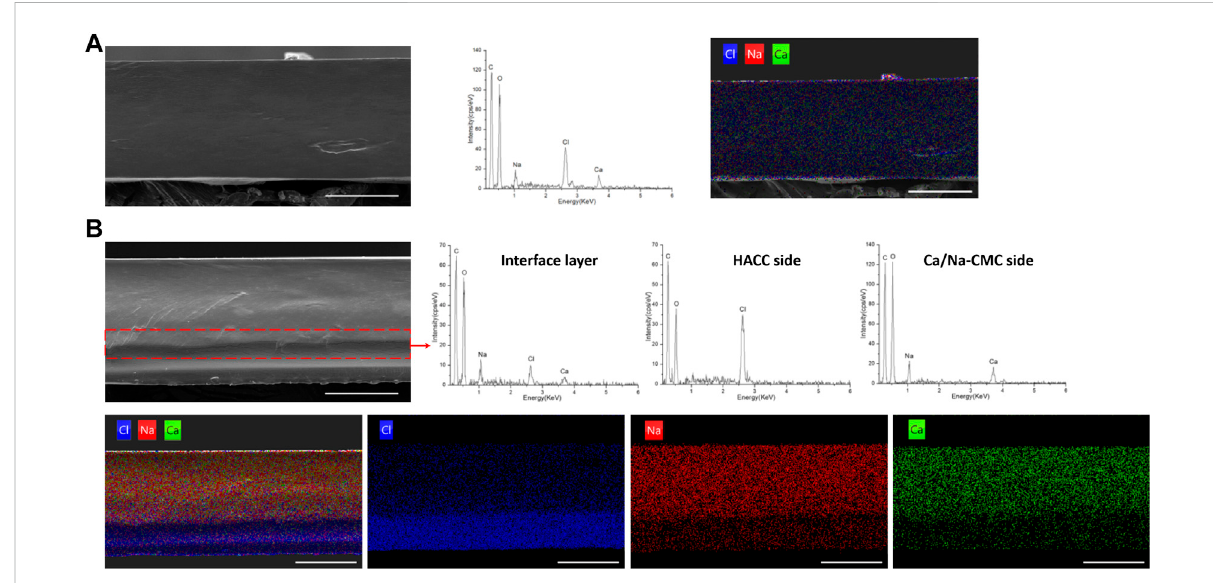
FIGURE 3 Morphology and composition analysis. (A) SEM image of the cross-section of BF, and corresponding EDS spectrum and mapping (chlorine, blue; natrium, red; calcium, green). (B) SEM image and corresponding EDS mapping of the cross-section of MF2, and EDS spectrum of the interface layer (in the dotted box), HACC side and Ca/Na-CMC side of MF2. (scale bar: 100 μ m)